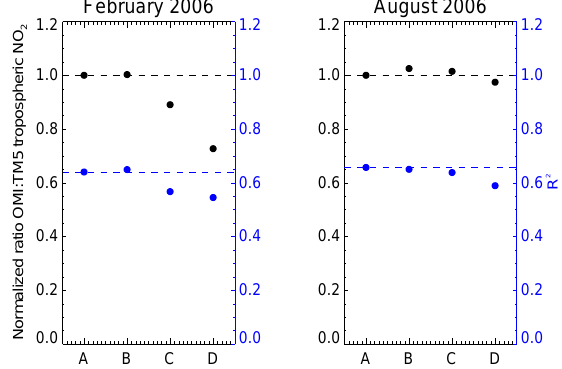
Figure 5. Impact of sampling strategy on monthly averaged OMI : TM5 ratio of tropospheric NO 2 columns (black dots) and on spatial correlation coefficient ( R 2 , blue dots) over the eastern United States (30–44 ◦ N, 90–72 ◦ W). Left panel: ratio and R 2 for February 2006 ( n = 28). Right panel: August 2006 ( n = 32). Grid cells were selected in the comparison when the covered fraction ex- ceeded 0.5. The dashed black line shows the normalized OMI : TM5 ratio for strategy (A), and the dashed grey line shows the R 2 for strategy (A) as a guide to the eye.